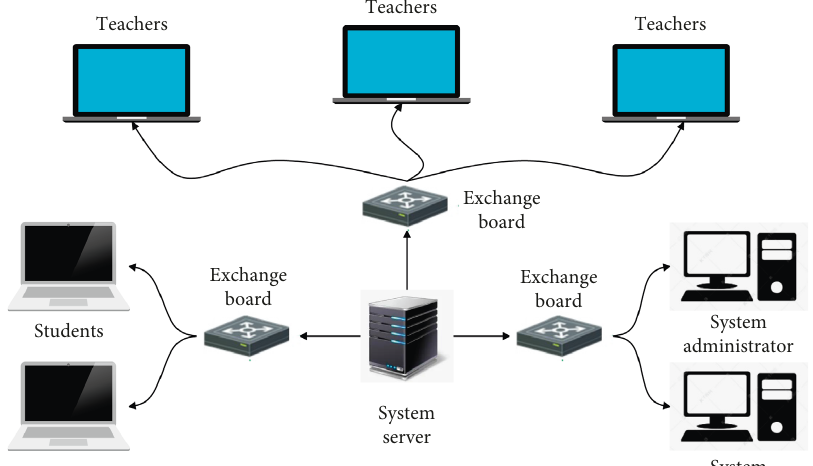
Figure 5: Structure diagram of the system network.